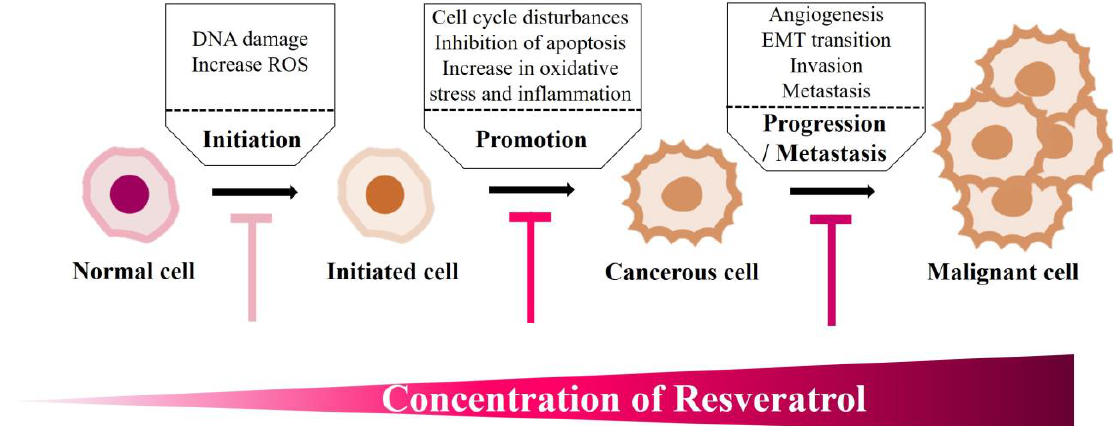
Figure 4. RE can affect all stages of carcinogenesis. RE can attenuate the various stages of